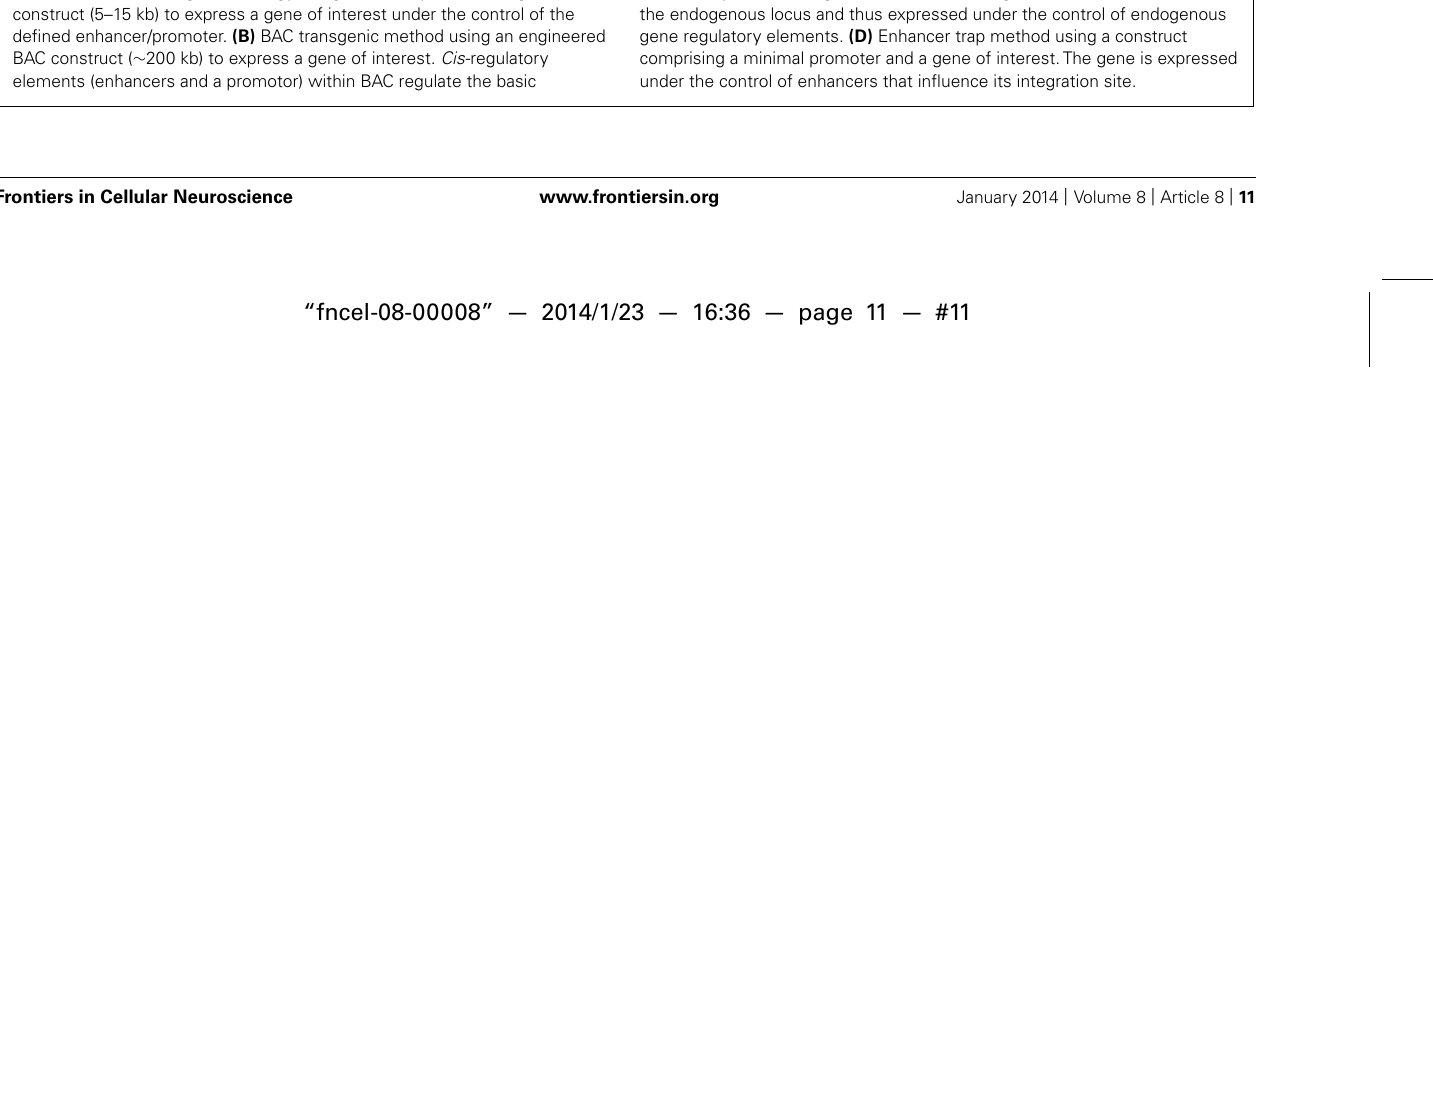
FIGURE 3 | Genetic strategies for targeted gene expression. (A) Conventional transgenic strategy using a relatively small transgenic construct (5–15 kb) to express a gene of interest under the control of the defined enhancer/promoter. (B) BAC transgenic method using an engineered BAC construct ( ∼ 200 kb) to express a gene of interest. Cis -regulatory elements (enhancers and a promotor) within BAC regulate the basic